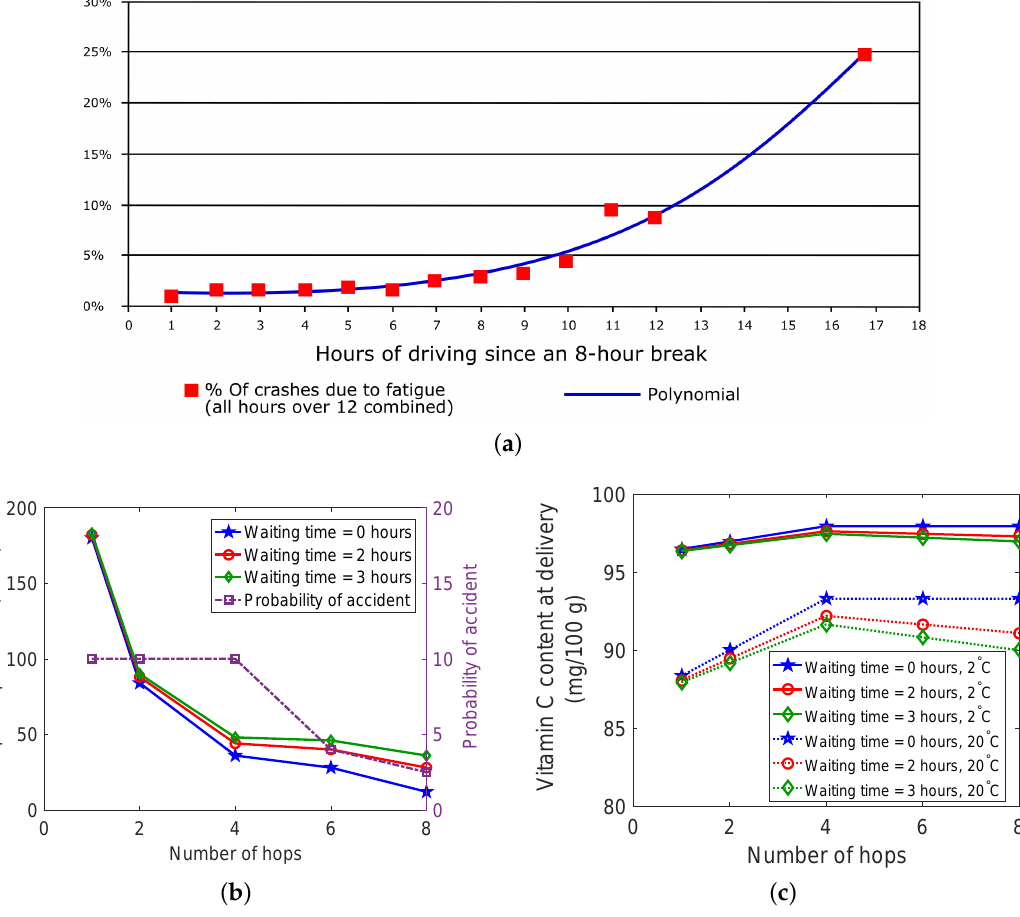
Figure 7. ( a ) The percentage of accidents due to fatigue as a function of hours of driving [28]. Variation of ( b ) the trip time of the drivers and ( c ) vitamin C content at delivery with the number of hops. The waiting time is the time taken at each intermediate hop to load/unload the packages in between different